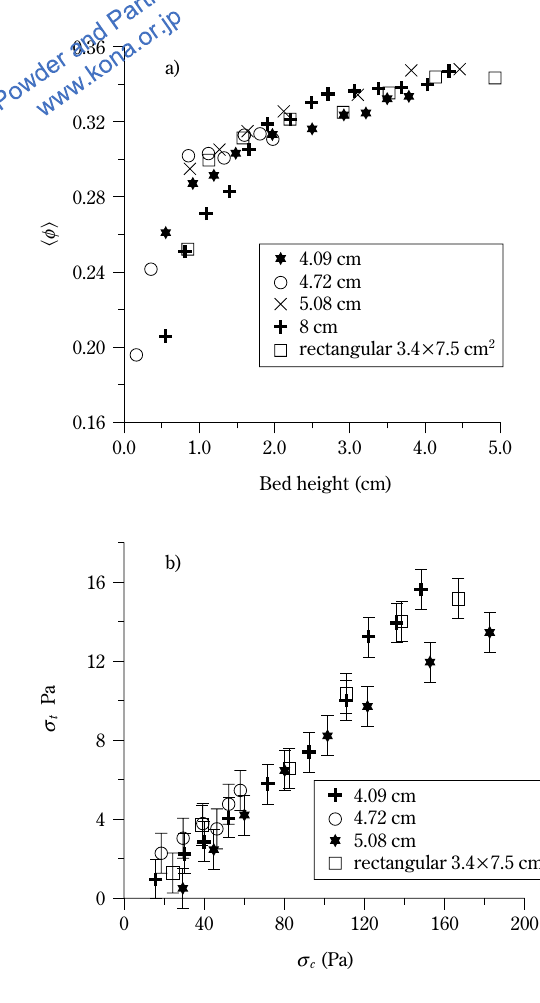
(a) Average particle volume fraction as a function of the bed height. (b) Test of the uniaxial tensile yield stress ver- sus consolidation stress. Data obtained for toner with 0.4% of additive obtained with different bed diameters (4.09 cm, 4.72 cm, 5.08 cm, 8.0 cm) and with a rectangular bed.